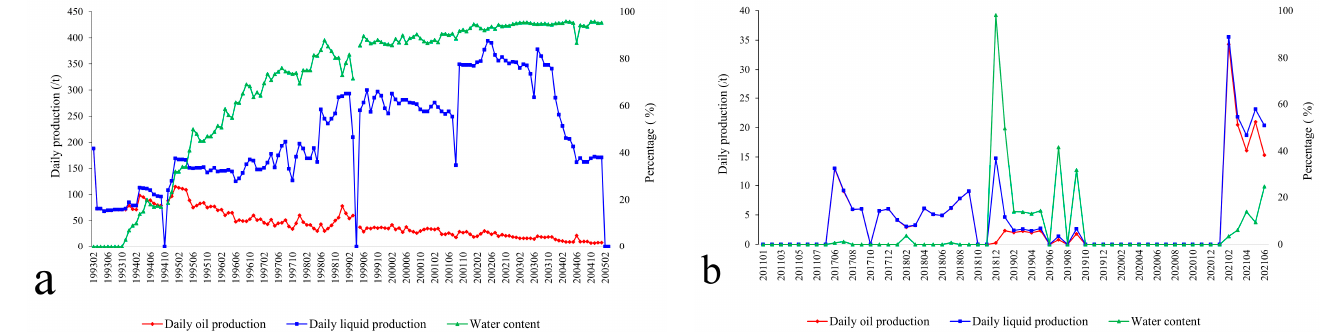
Figure 10. Production curve of wells X1 and X2 in the Sangtamu oilfield. ( a ) Wel X1. ( b ) Well X2.